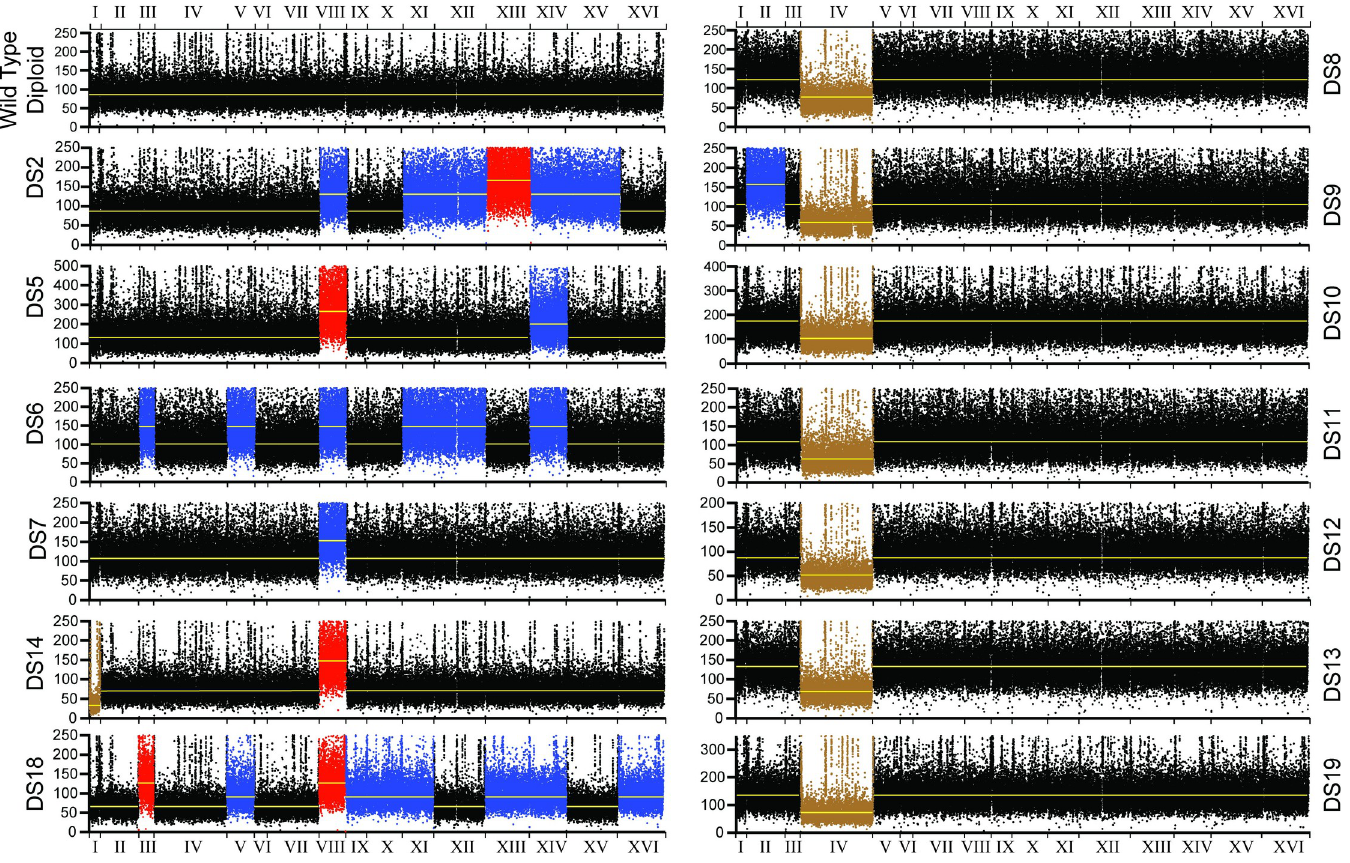
Fig 1. Aneuploidy in 2DG-resistant diploid strains. Diploid strains were sequenced, and the read depth (y-axis) is plotted against chromosomal position (x-axis) with chromosome number shown in Roman numerals. Median read depth is indicated with a yellow line. Monosomic chromosomes are plotted in brown, trisomic chromosomes in blue and tetrasomic chromosomes in